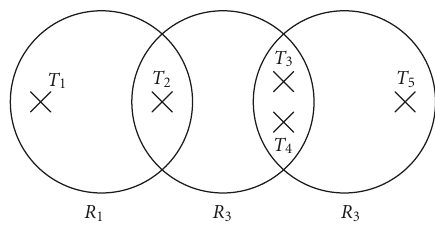
Figure 3: The second example of redundant